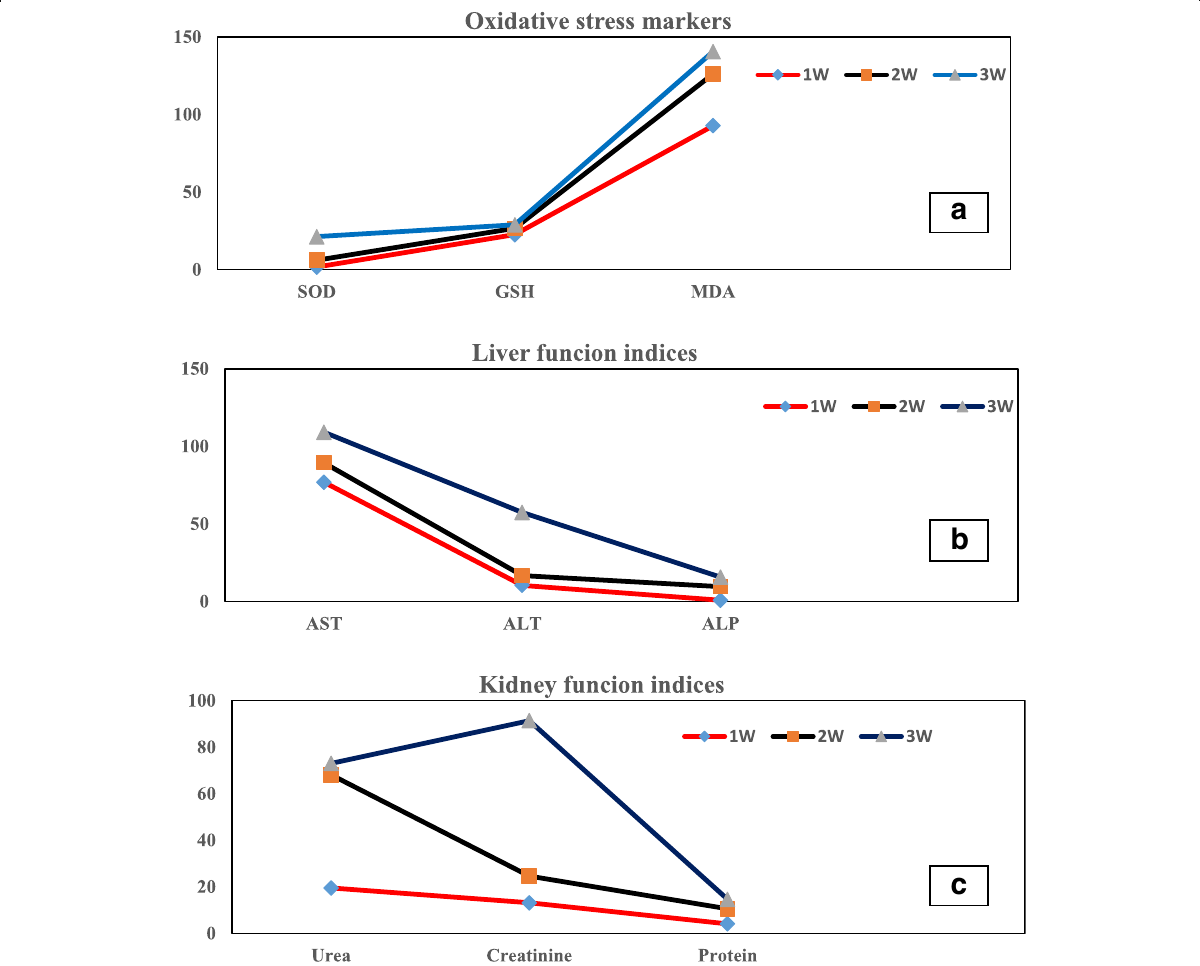
Fig. 1 Recovery percentages of oxidative stress markers, liver function enzymes, and kidney function indices in ketoprofen-treated rats left free without treatment for one ( a ), two ( b ), and three ( c )